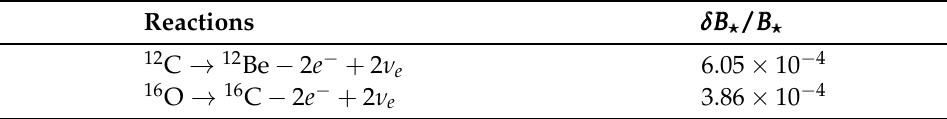
Table 10. Same as Table 9 for B (cid:63) =